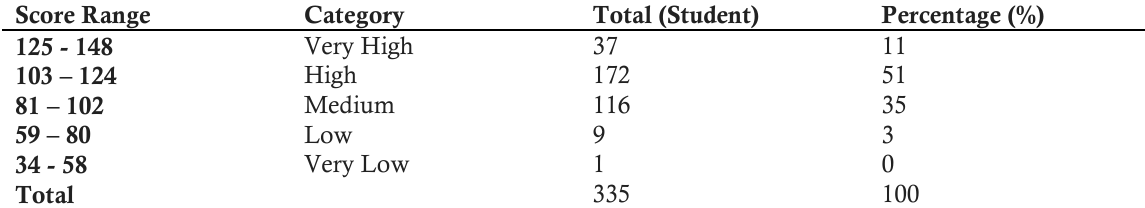
Table 2. Classification of Student Self-efficacy Scores